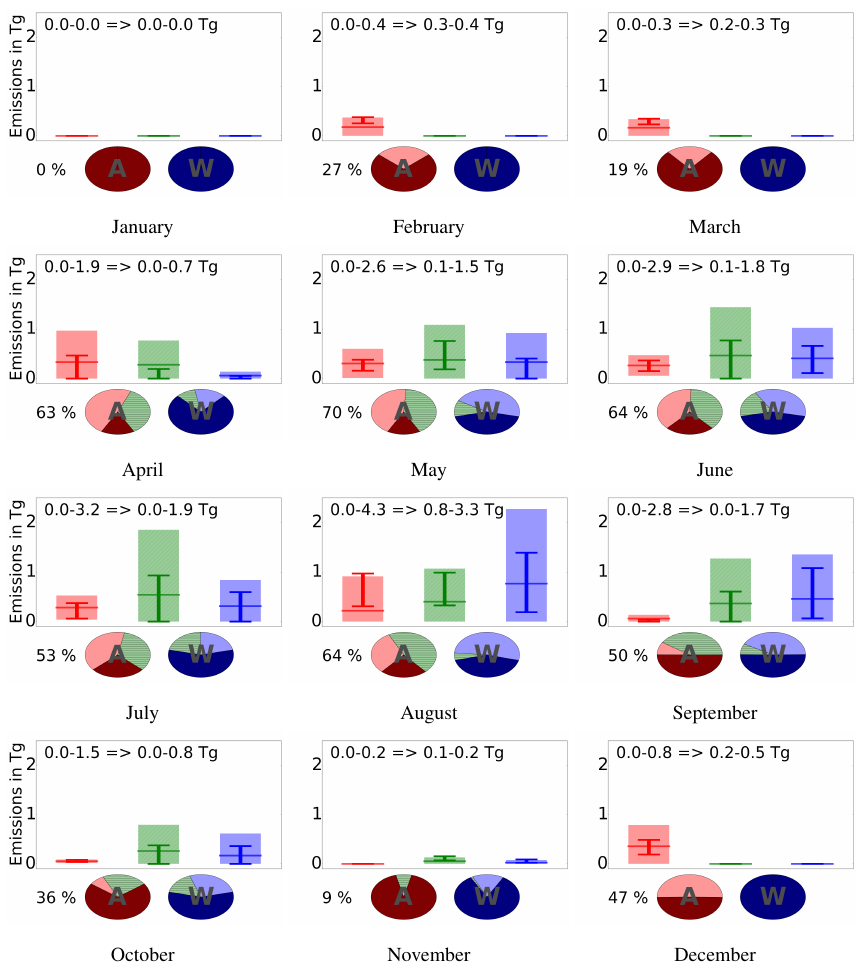
Figure 5. Inversion results for the 12 months of 2010 in the Siberian lowlands (hatched area in Fig. 1). For each month, the bar plots show the prior (shade) and posterior (bar) tolerance intervals (in TgCH 4 ) for anthropogenic (left), mixed (middle) and wetland (right) emissions. The pie charts depict the proportion of prior emissions within regions constrained by the inversion (in term of mass): (left, A) anthropogenic, (right, W) wetlands. Dark portions mean no constraint; lighter shade shows constrained regions; the hatched green portions are for the emissions which are mixed with the other emission type. The percentage indicates the fraction of the total emissions that is constrained each month. The given intervals in TgCH 4 are for the prior and posterior constrained Siberian budgets. See Sect. 2.3.3 for